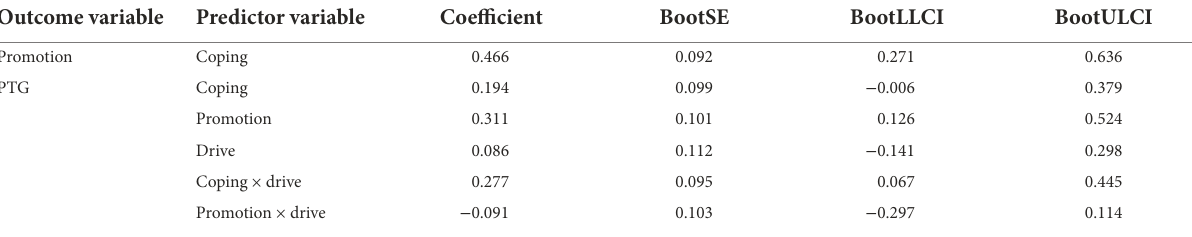
TABLE 4 Bootstrap results for regression model